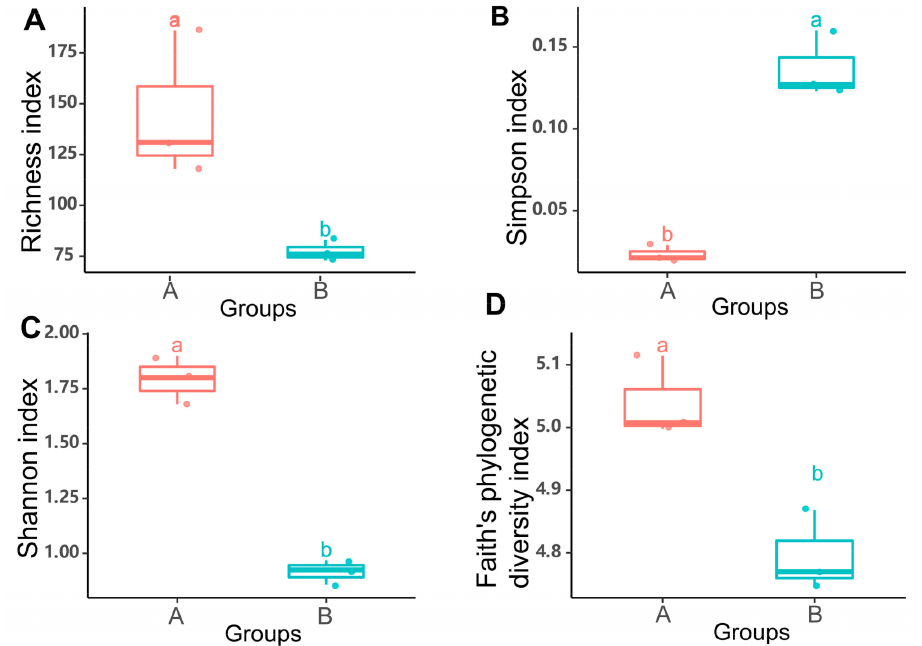
Figure 4. The alpha diversity indices including ( A ) ZOTUs (zero-radius operational taxonomic units) richness, ( B ) Simpson, ( C ) Shannon diversity index, and ( D ) Faith’s phylogenetic diversity index for obtained gill-associated microbial communities of G. haimaensis (Group A) and A. marissinica (Group